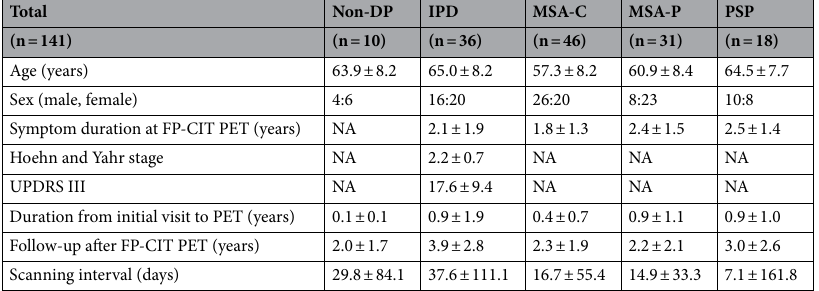
Table 1. Demographics and clinical characteristics. Non-DP non-degenerative parkinsonism, PET positron emission tomography, FU follow-up, IPD idiopathic Parkinson’s disease, MSA-P multiple system atrophy, Parkinson type, MSA-C multiple system atrophy, cerebellar type, PSP progressive supranuclear palsy, UPDRS unified Parkinson’s disease rating scale, NA not